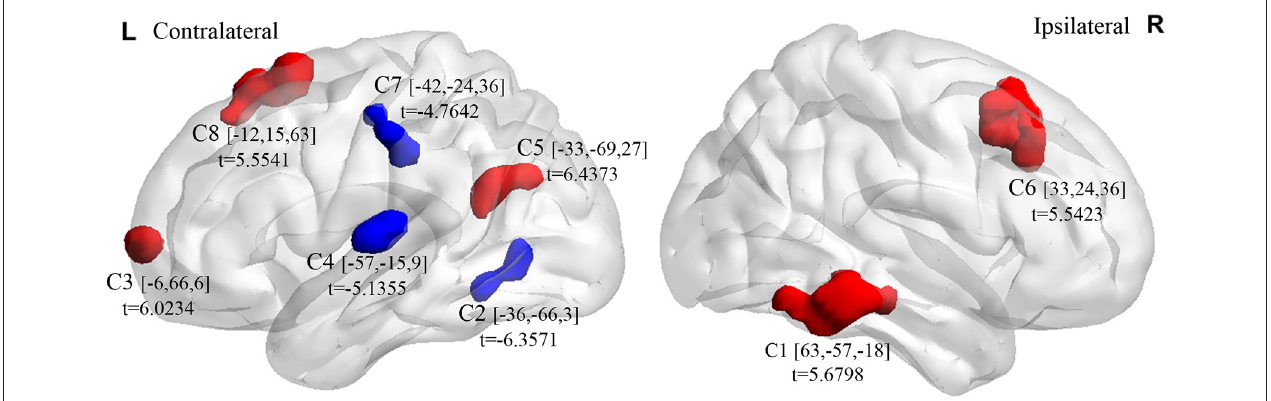
FIGURE 1 | Brain clusters (C1–C8) exhibiting intergroup differences in ALFF between congenital microphthalmia (CM) and normal controls (NC). Blue color indicates decreased spontaneous neuronal activity, whereas red color indicates increased spontaneous neuronal activity. The peak t -values and the corresponding MNI coordinates were presented near the clusters. ALFF, amplitude of low-frequency fluctuation. MNI, Montreal Neurological